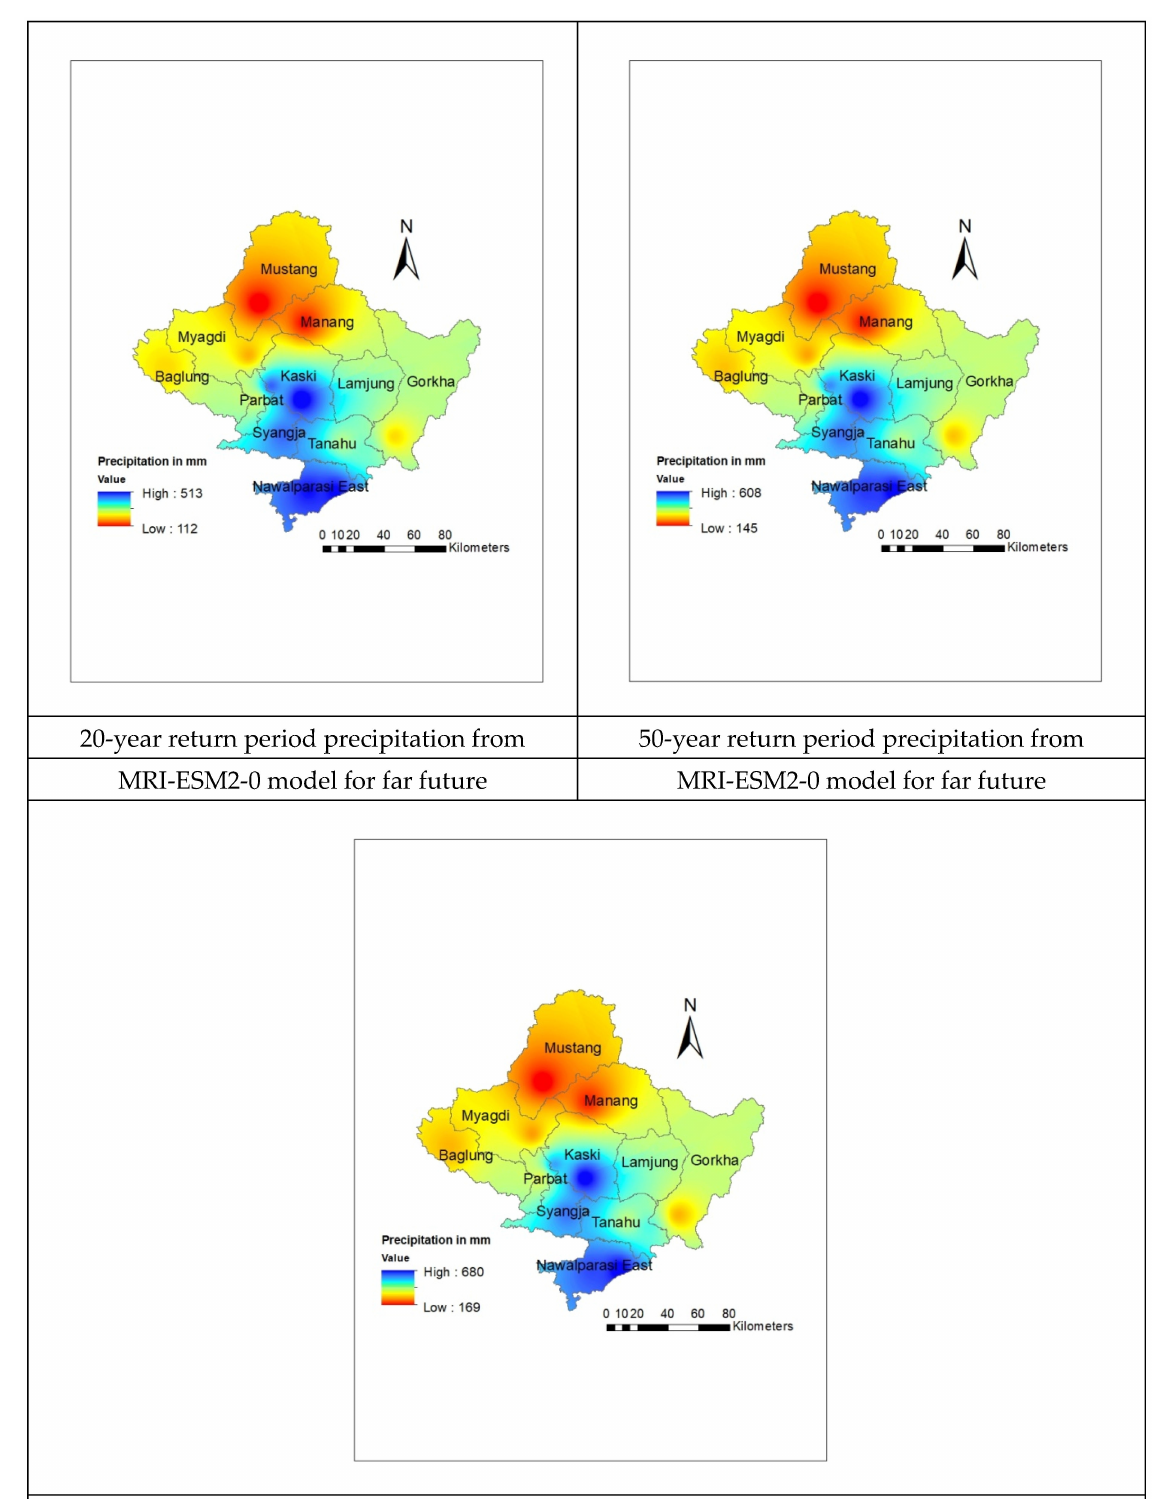
Figure A15. Projected spatial annual daily extreme